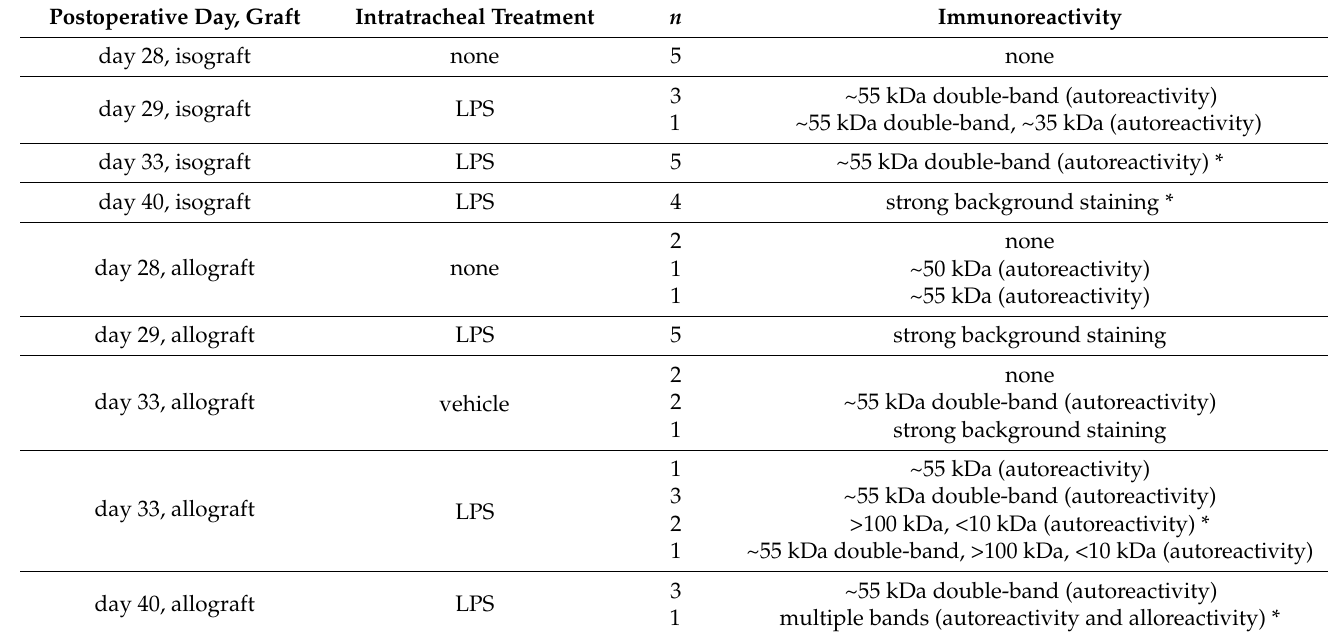
Table 2. Immunoreactivity of IgG of sera from lung transplant recipients on Western blots of protein extracts of Lewis and Fischer-344 rat